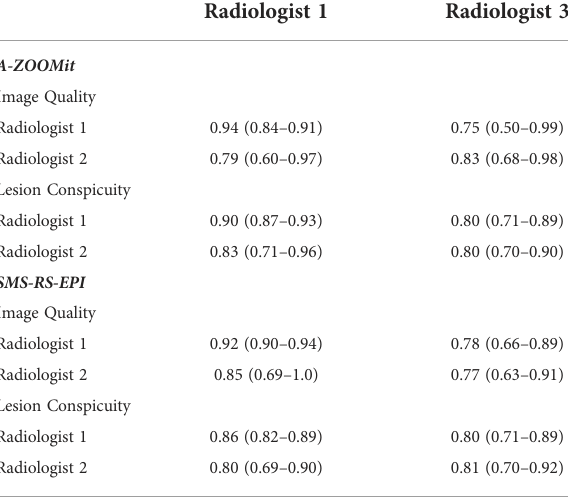
TABLE 2 Intra- and interclass correlation coef fi cients of multireader ratings of image-quality and lesion conspicuity on A-ZOOMit and SMS- RS-EPI.